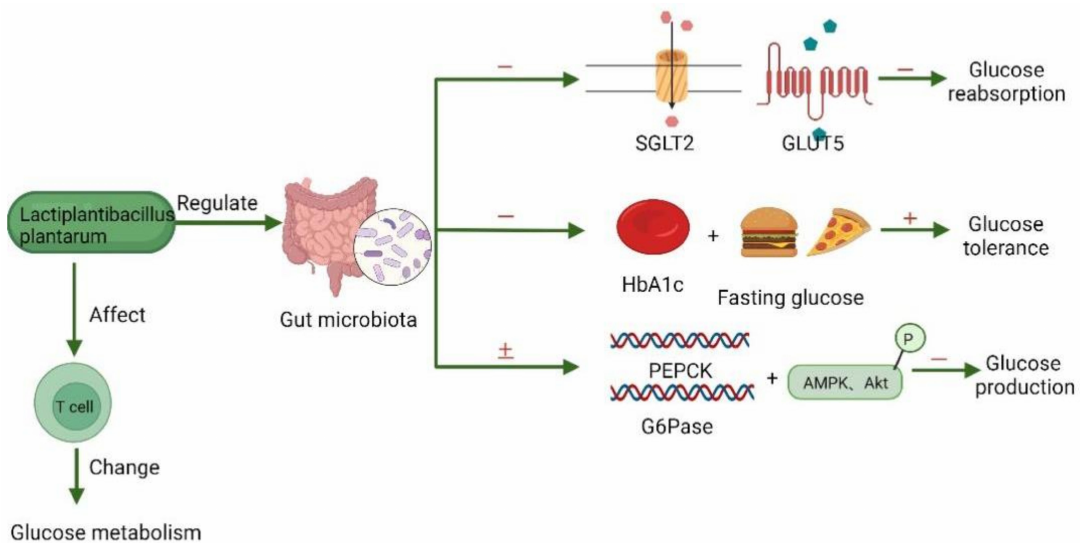
Figure 4. The blood glucose lowering mechanism of Lactiplantibacillus plantarum. Lactiplan- tibacillus plantarum lowering glucose level through gut microbiota, which can regulate the expression of Phosphoenolpyruvate carboxykinase (PEPCK) and Glucose-6-phosphatase (G6Pase), as well the Adenosine 5‘-monophosphate activated protein kinase (AMPK)/protein kinase B (Akt) signaling pathway, meanwhile reducing the level of transporter SGLT2, GLUT5, glycated hemoglobin (HbA1c), and fasting glucose. Immune cell function is regarded as a possible mechanism but still needs further study. (“+” means upregulation, “ − “ means downregulation and “ ± “ means upregulation or downregulation) (Created with